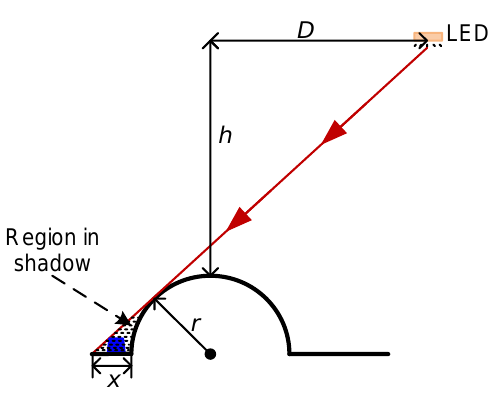
Figure 2. Shadow caused by a point light source.